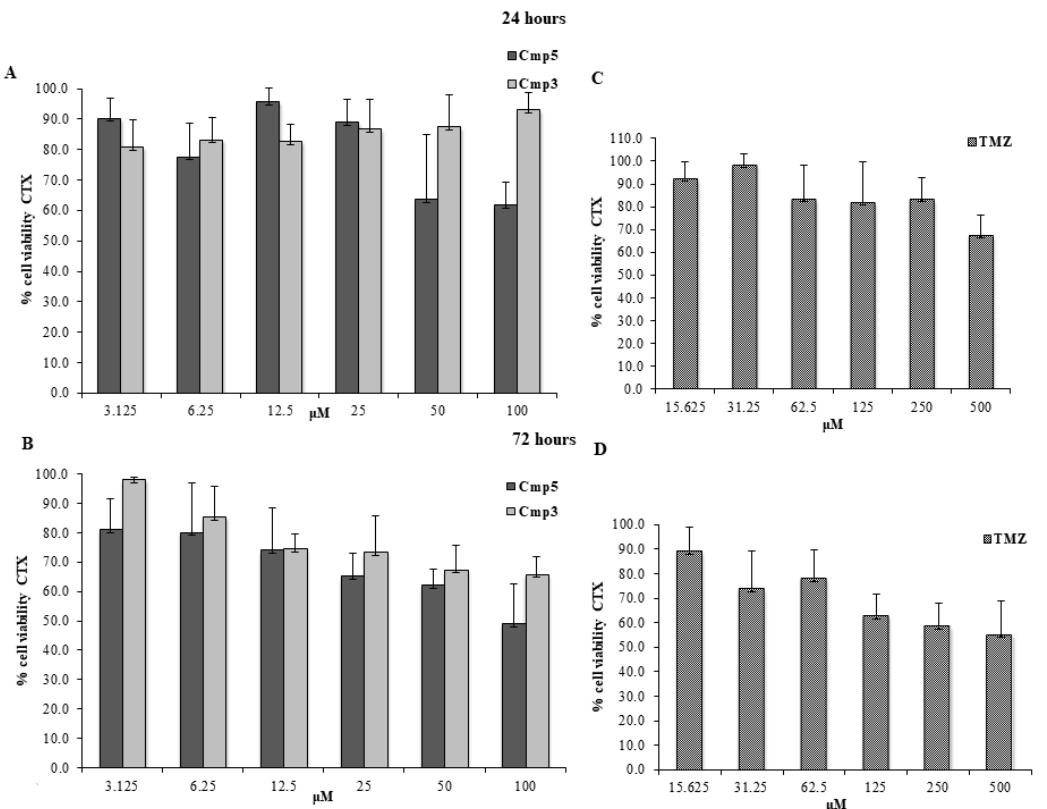
Figure 2. MTT cell viability assay on CTX. ( A,B ) Histograms represent the viability dose-response of CTX cells exposed to different concentrations of Cmp 3 and Cmp 5 (from 3.125 to 100 μM) for 24 h and 72 h, respectively. ( C,D ) Histograms represent the viability dose-response of CTX cells exposed to different concentrations of TMZ (from 15.636 to 500 μM) for 24 h and 72 h. Proliferation was assessed using MTT assay and normalized to control cells treated with DMSO (0.2% as final concentration).